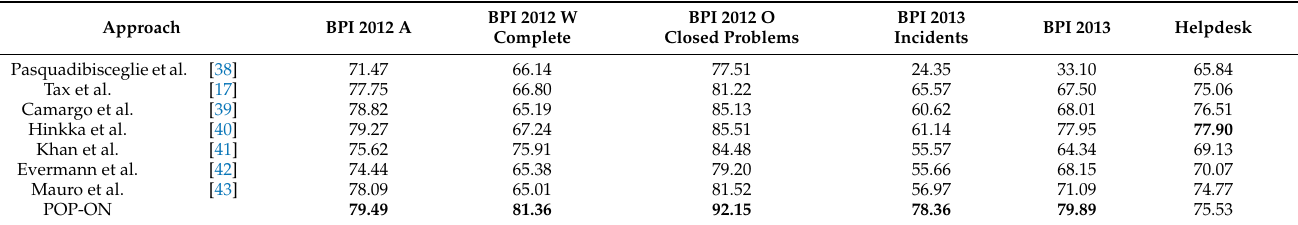
Table 3. Benchmark (accuracy) between existing deep learning-based process prediction research and POP-ON. The bold numbers in the table represent the best results for each dataset.